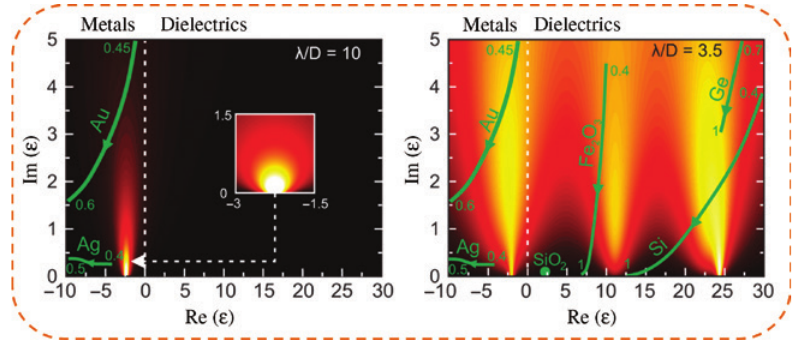
Figure 4: Calculated resonant heating maps for a spherical NP with diameter D in the air for different real and imaginary parts of permittivity made for various ratios of wavelength λ to D